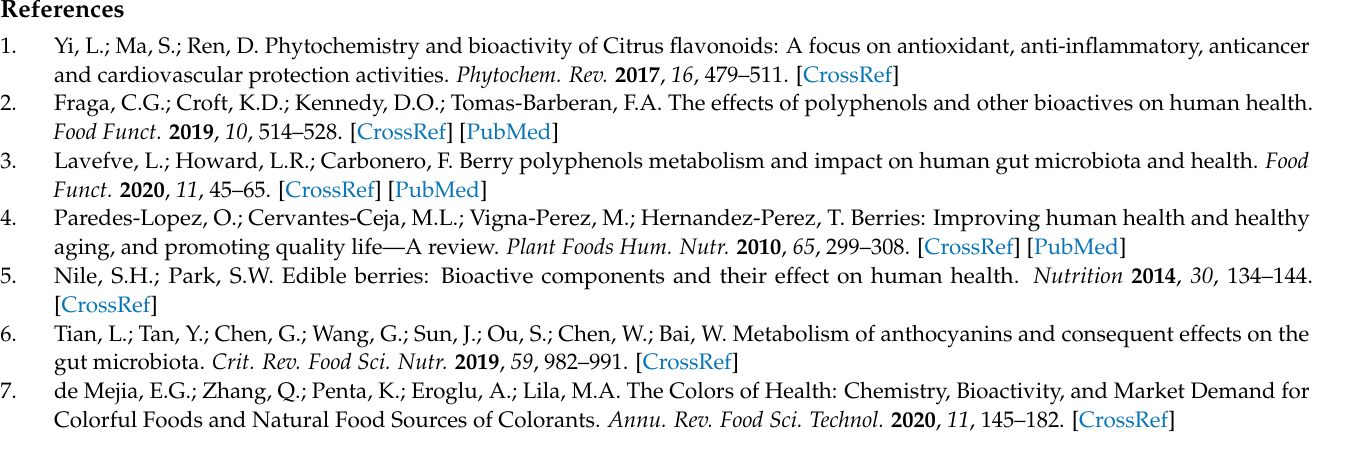
Figure S3: Partial least squares discriminant analysis (PLS-DA) of the gut microbiota composition at the operational taxonomic unit (OTU) level from different groups. Figure S4: Alpha diversity analysis of gut bacterial diversity (Simpson index) from different mouse groups. Figure S5: Bacterial taxonomic profiling of gut bacteria from different mouse groups. Figure S6: Spearman